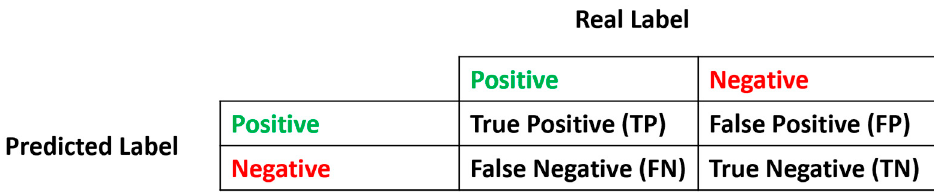
Figure 13. Confusion matrix for calculating TPR and FPR.